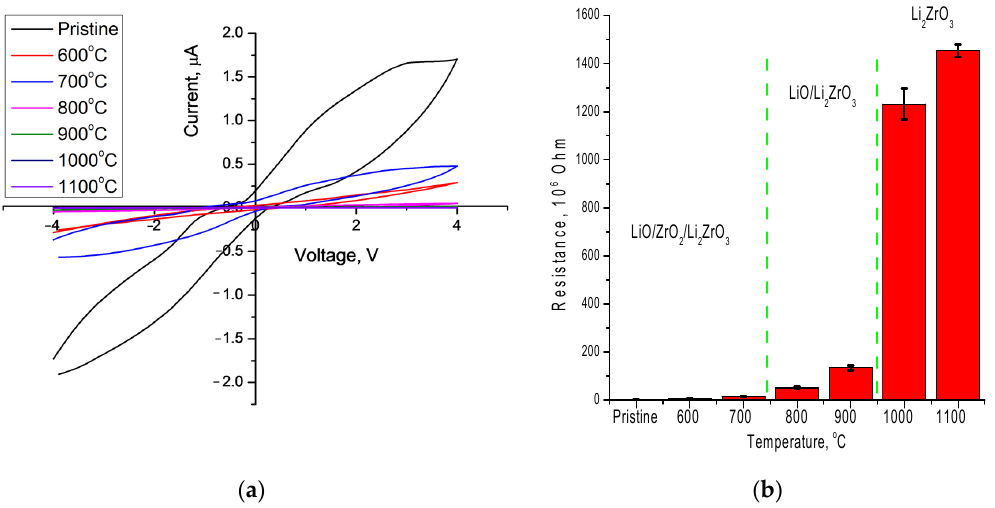
Figure 6. ( a ) IVC graphs of the studied ceramics; ( b ) resistance diagram of the ceramics. The general view of the loops of current-voltage characteristics for the initial sample indicates the presence of a large number of oxygen vacancies in the structure, which leads to broadening of the loop. This behavior of the loops for the initial sample, as well as for the samples annealed at temperatures of 600–700 °C, is caused by the occurrence of impu- rity LiO and ZrO 2 phases in the structure, the presence of which determines the presence of free charge carriers, thereby reducing the resistance. A rise in the structural ordering degree and the displacement of impurity inclusions from the structure leads to growth in the resistance and restoration of the dielectric nature of the ceramics. The difficulties of the applied method include the fact that, at annealing temperatures below 1000 °C, the presence of impurity phases is observed in the structure of ceramics, which lead to the appearance of additional distortions, as well as the appearance of free charge carriers, the presence of which determines the high conductivity of ceramics. An increase in the annealing temperature above 1000 °C leads to the completion of phase transformations with the displacement of impurity phases from the structure, as well as the compaction of ceramics and a decrease in porosity. 4. Conclusions In conclusion, we can summarize the results of the experimental work. During per- formed experiments, the dynamics of structural and phase orderings in Li 2 ZrO 3 ceramics versus the annealing temperature was established. A two-stage character of phase trans- formations was established in relation to the annealing temperature, including the dis- placement of impurity LiO and ZrO 2 phases, followed by structure ordering and a de- crease in porosity at temperatures above 900 °C. The general scheme of phase transfor- mations in ceramics is established depending on the annealing temperature, which can be written as LiO/ZrO 2 /Li 2 ZrO 3 → LiO/Li 2 ZrO 3 → Li 2 ZrO 3 . Analysis of the optical properties of ceramics showed that a change in the phase composition, accompanied by the displace- ment of impurity phases, leads to an increase in absorption and a change in the transmis- sion of ceramics. During analysis of the obtained current-voltage characteristics depend- ing on the annealing temperature, it was revealed that the formation of the ordered Li 2 ZrO 3 phase in the structure results in a rise in resistance by three orders of magnitude, which indicates the dielectric nature of the ceramics. The practical significance of the work includes the obtained dependencies of phase formation processes in Li 2 ZrO 3 ceramics, which make it possible to conclude that the use of the proposed mechanochemical synthesis method with consequential thermal